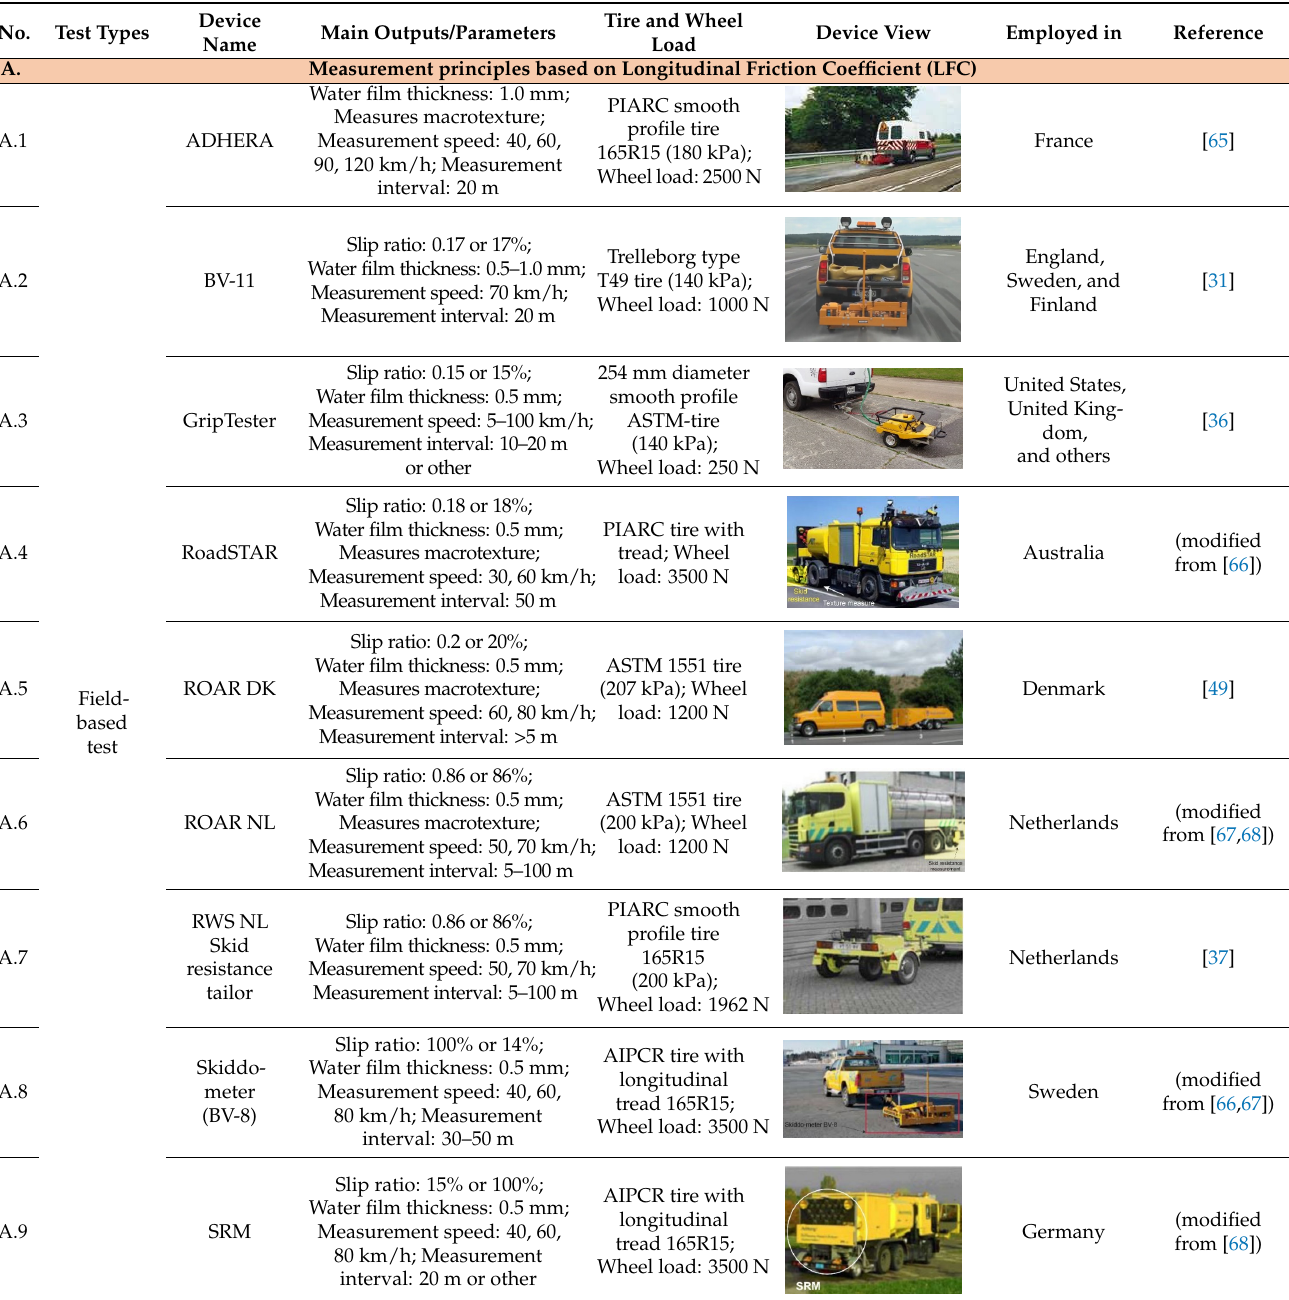
Table 5. Simplified/summary list of friction/skid resistance measurement techniques.